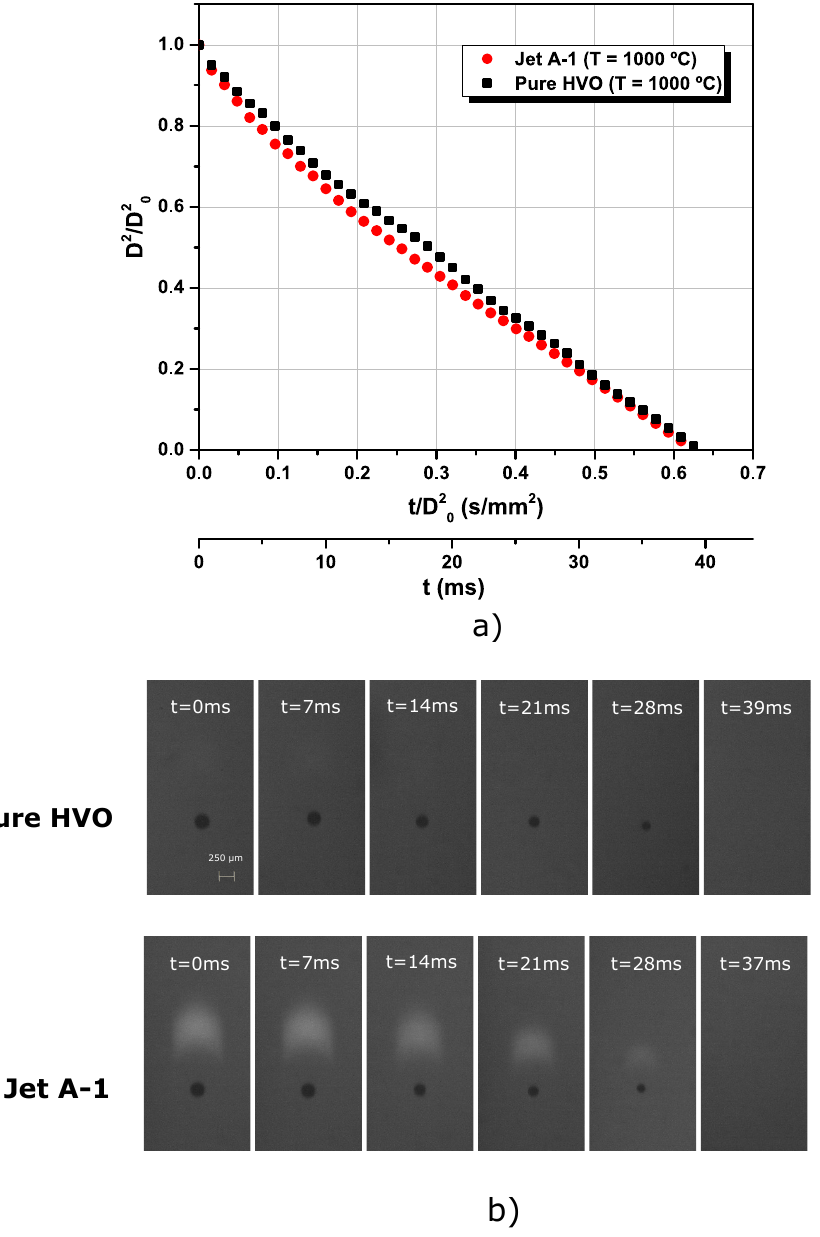
Figure 9. Jet A-1 and HVO combustion at T = 1000 ◦ C: ( a ) Droplet size evolution; ( b ) Sequence of imagens of burning